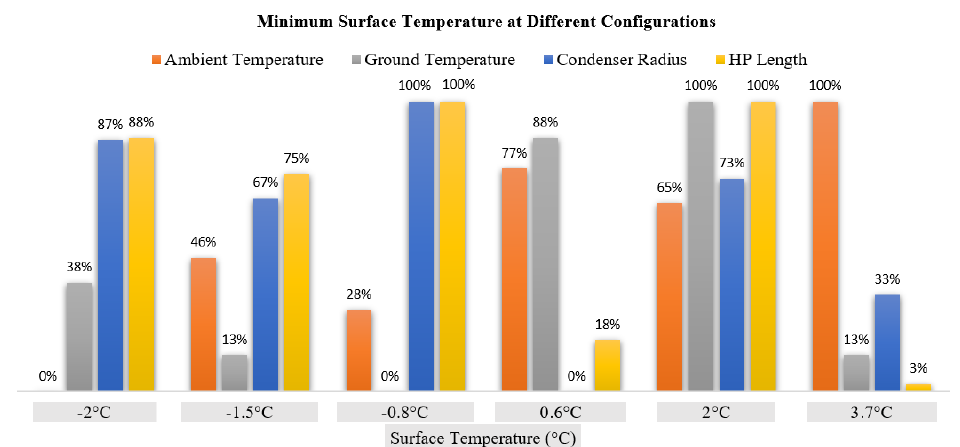
Figure 12. Normalized GSHP simulation results to compare effects of ambient temperature, ground temperature, condenser radius, and heat pipe length.